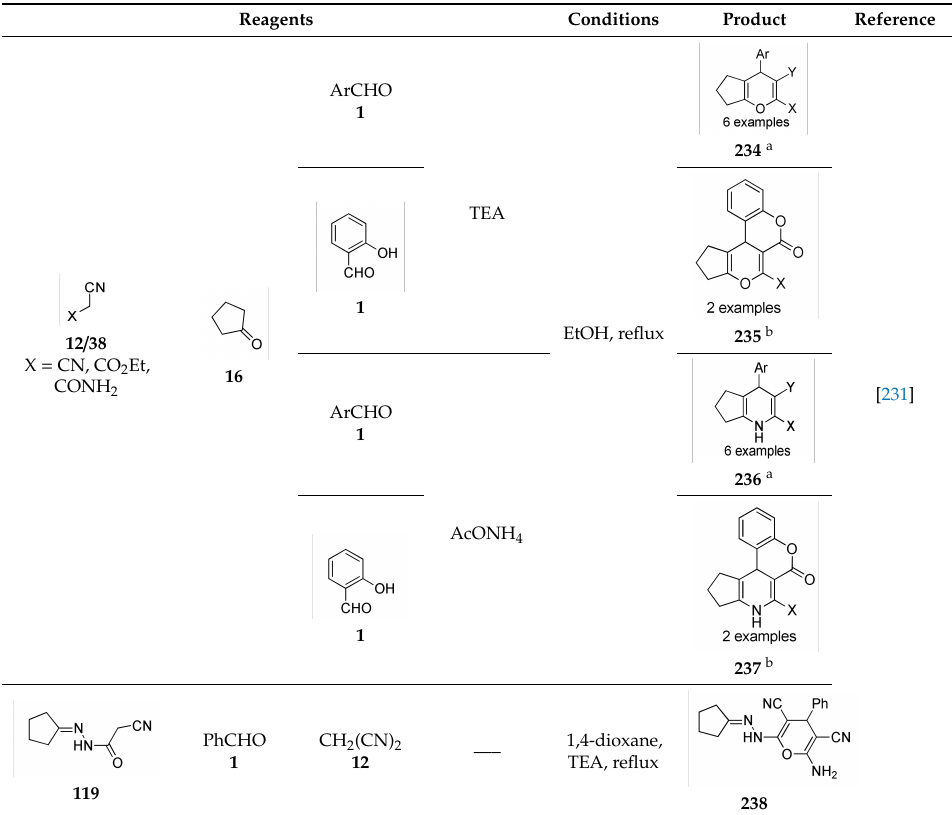
Multicomponent synthesis of cyclopentanone-based dihydropyran / dihydropyridine heterocyclic systems 234 – 238 of potential anticancer